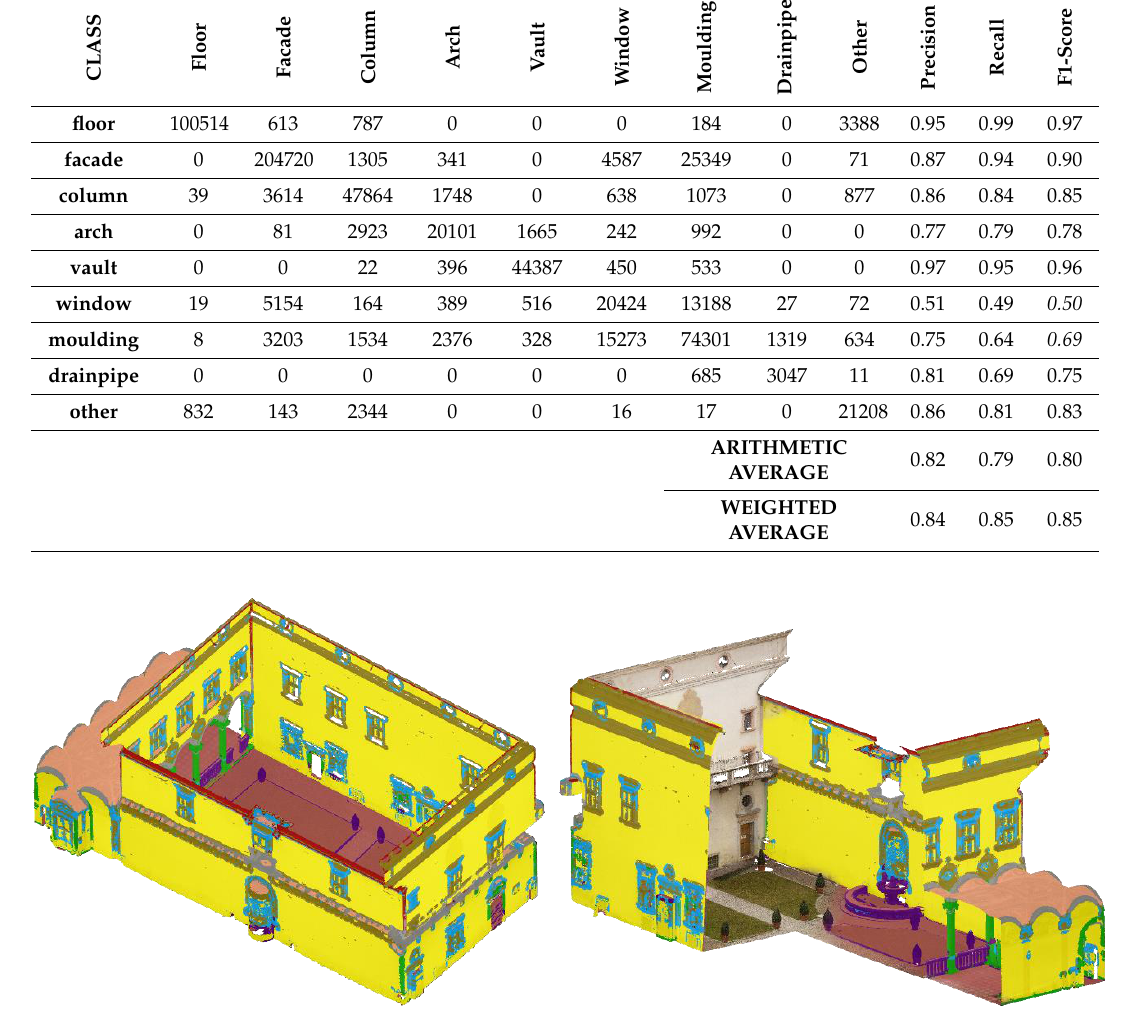
Table 6. Evaluation metrics: generalisation level #3, dataset E. The most critical F1 values are reported in italics.